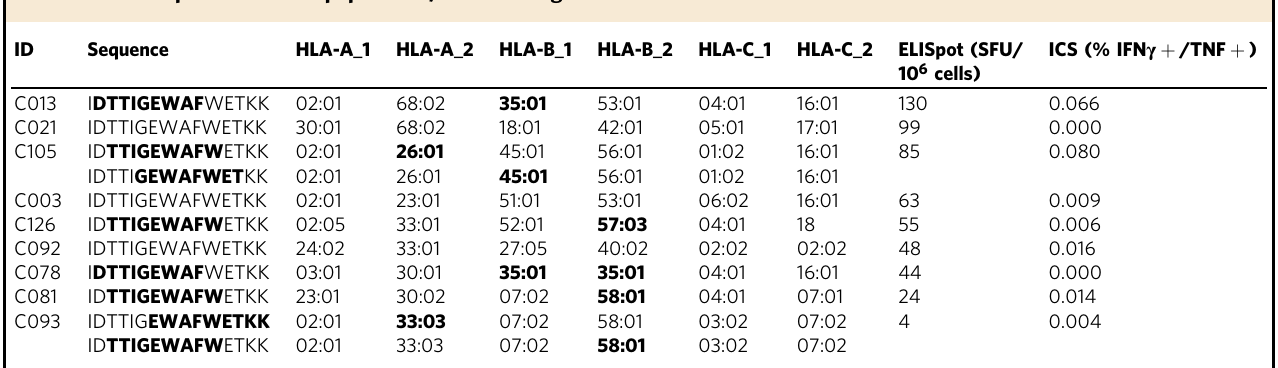
Table 1 In silico predictions for peptide 82/HLA binding to CD8 +